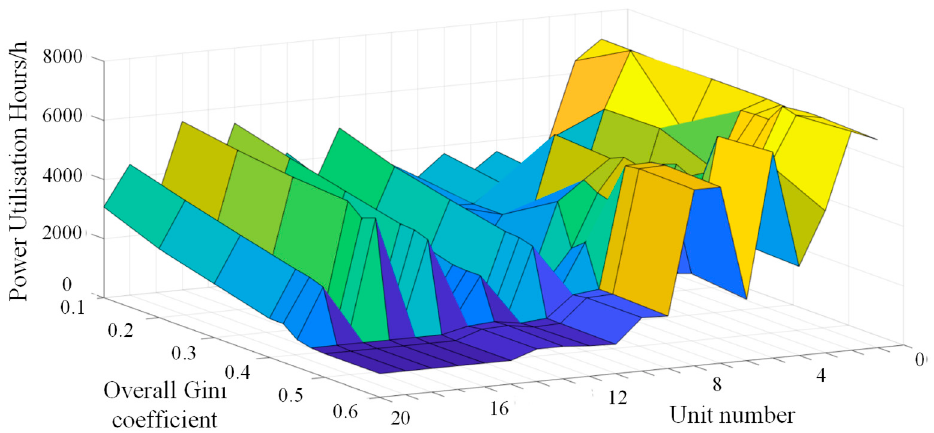
Figure 3. Annual planned electric generation hour curve of each unit under various overall Gini coefficient values.